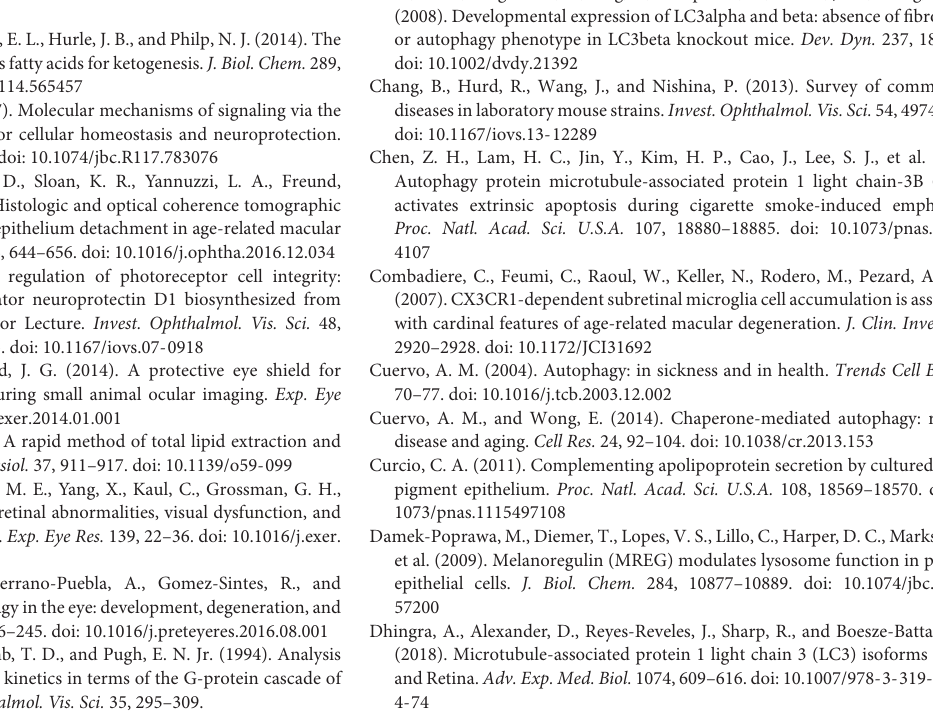
FIGURE S1 | (A) Representative immunoblots showing expression of LC3B in the RPE (using a second LC3-B antibody, D11) from 4, 12, 16, and 20 months old mice. (B) Representative immunoblot showing levels of HMGCS2 in LC3B − / − and WT RPE. (C) Mean ( ± SEM) HMGCS2/actin levels in LC3B − / − and WT RPE. (D) . Citrate synthase activity in RPE explants from LC3B − / − and WT RPE isolated at 7 am. Data (C,D) represents 3 mice (6-eyes) of 12–15 month old animals. FIGURE S2 | Electron micrographs from ∼ 4 months old WT and LC3B − / − retina at 7:30 am (30 min after light onset) and 2 pm (7 h after light onset), showing phagosome accumulation (arrows). FIGURE S3 | (A) Representative confocal image of neutral lipid deposits detected by staining with BODIPY 493 / 503 in WT and LC3B − / − mouse RPE (2 and 18 months). (B) Confocal image showing filipin staining in RPE (left), low magnification image (right) from WT and LC3B − / − (18 months) mice. (C) Confocal image showing 4-HNE immunostaining of WT (27 months) and LC3B − / − (24 months) retina. FIGURE S4 | (A) Confocal images of RPE flat mount from 18 months old WT (left) and LC3B − / − (right) immuno-stained for Iba1 (red), F-actin (green). (B) Confocal images of superior (left) and inferior (right) areas of RPE flat mounts from LC3B − / − immuno-stained for Iba1 (red), F-actin (green) (age ∼ 18 months). (C) Representative confocal images of WT and LC3B − / − retina immuno-stained for rhodopsin (4D2, green) and no primary control for Iba 1 (secondary: anti rabbit IgG Alexa Fluor 594, red). OS, outer segments; ONL, outer nuclear layer; INL, inner nuclear layer). (D) Bar graph showing mean weight of age-matched WT and LC3B − / − mice at 2, 7.5, and 18 months. The weights of 10 mice per age were measured and represent an equal number of male and female